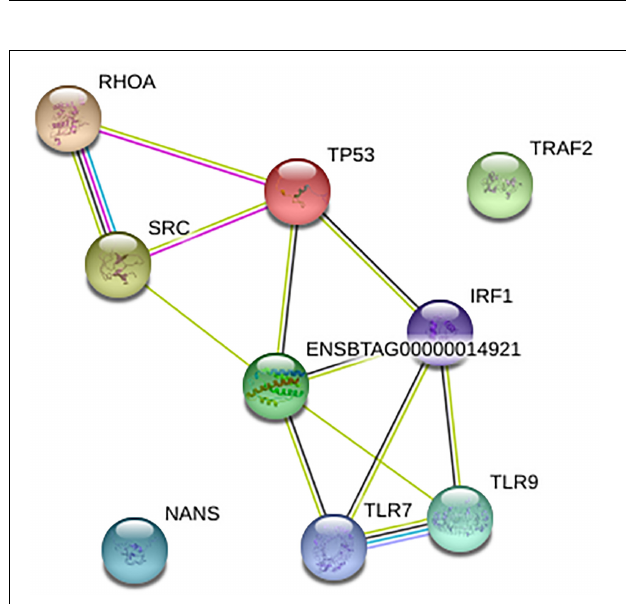
FIGURE 3 | Network for nine of the final genes created using STRING. The Ensembl ID represents cytokine IL-6.